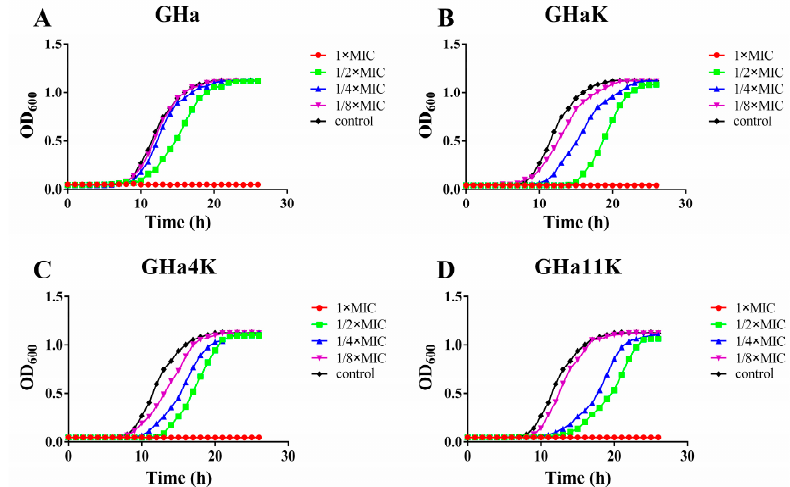
Figure 2. Growth inhibition kinetics of ( A ) GHa, ( B ) GHaK, ( C ) GHa4K, and ( D ) GHa11K. The growth of S. aureus (OD600) was grown in TSB broth for 26 h in the presence of 1 × MIC, 1/2 × MIC, 1/4 × MIC and 1/8 × MIC peptides, with PBS as the control.